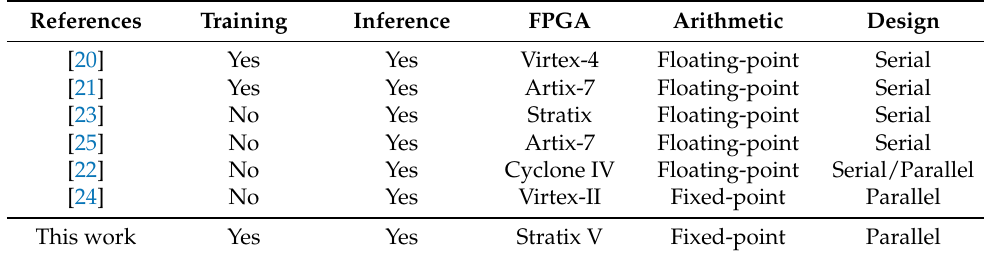
Table 1. Summary of the proposal’s architectural characteristics and other works in the